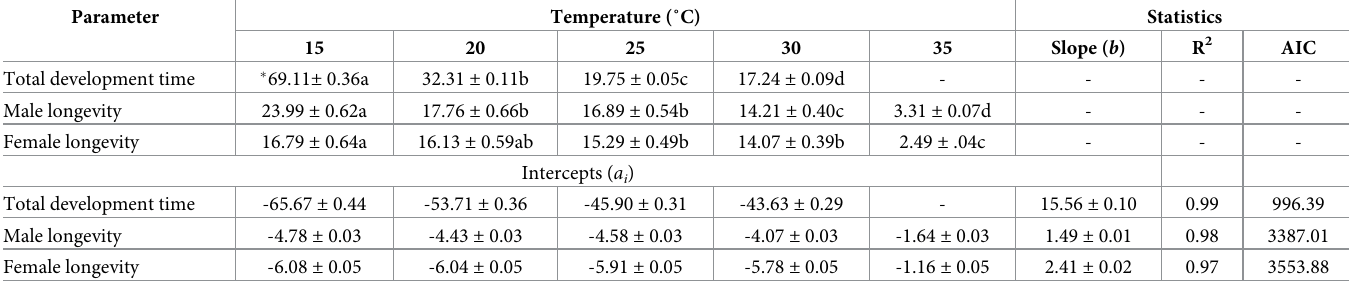
Table 1. Development time and adult longevity (mean ± SE in days) of Diachasmimorpha longicaudata with the parameters (y-intercept a , common slope b ) of logit and complementary log-log distributions functions fitted to the cumulative development and adult longevity at five constant temperatures.